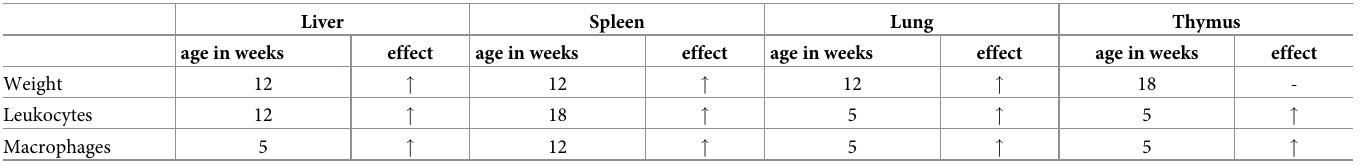
Table 3. Summary of visceral changes in 4L/PS-NA mice compared to control animals. Liver Spleen Lung Thymus